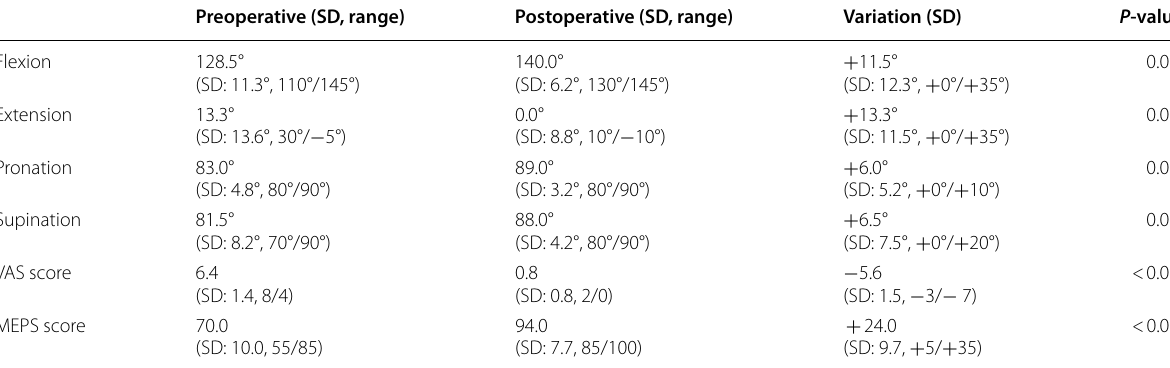
Overall clinical results of the OCD group patients. For each measured outcome (flexion, extension, pronation, supination, VAS score, and MEPS score) the preoperative and postoperative means (with SD standard deviation and range with minimum / maximum value obtained), the variation, and the P -value are